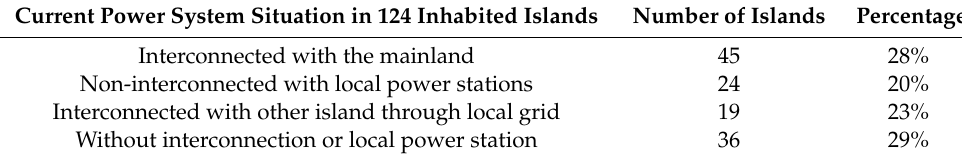
Table 1. Overview of the current power system situation in Greek